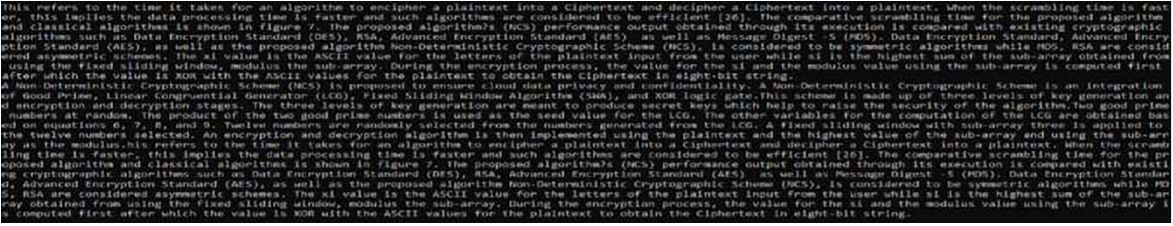
Fig 13. Decrypted